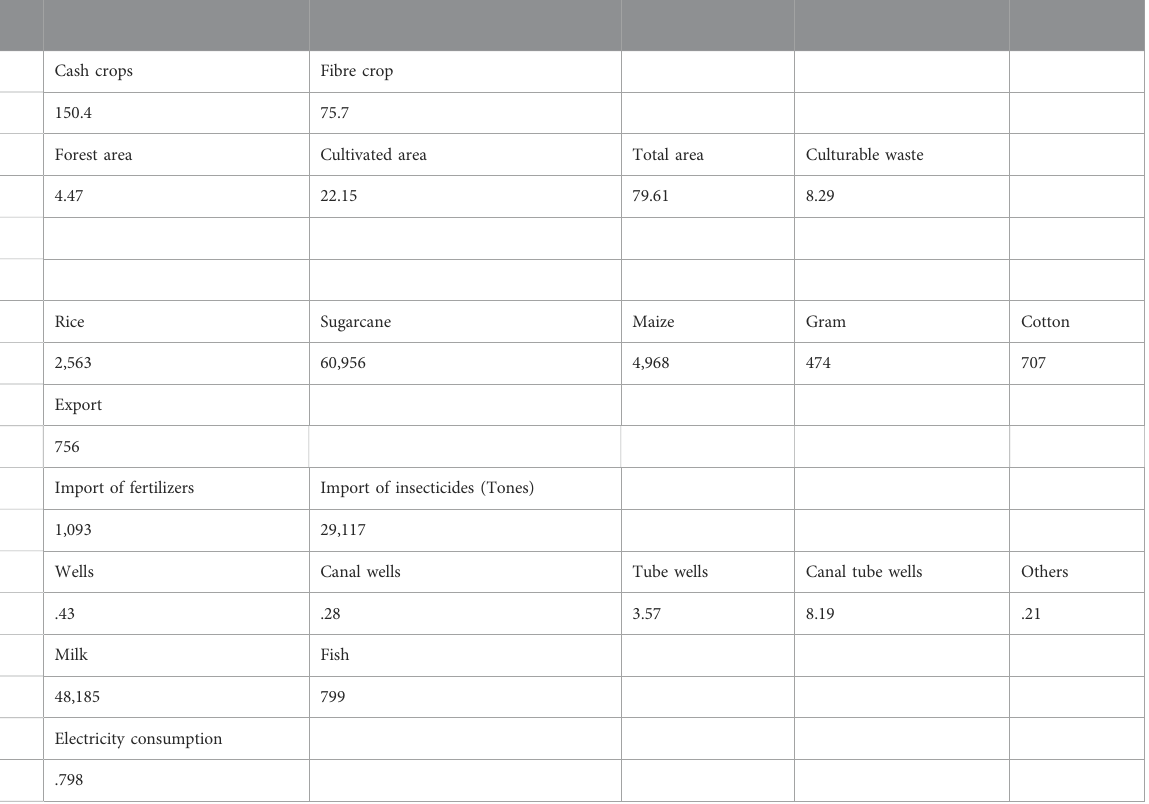
TABLE 2 Overall farming activity of Pakistan as of 2019 (Pakistan Economic Survey,